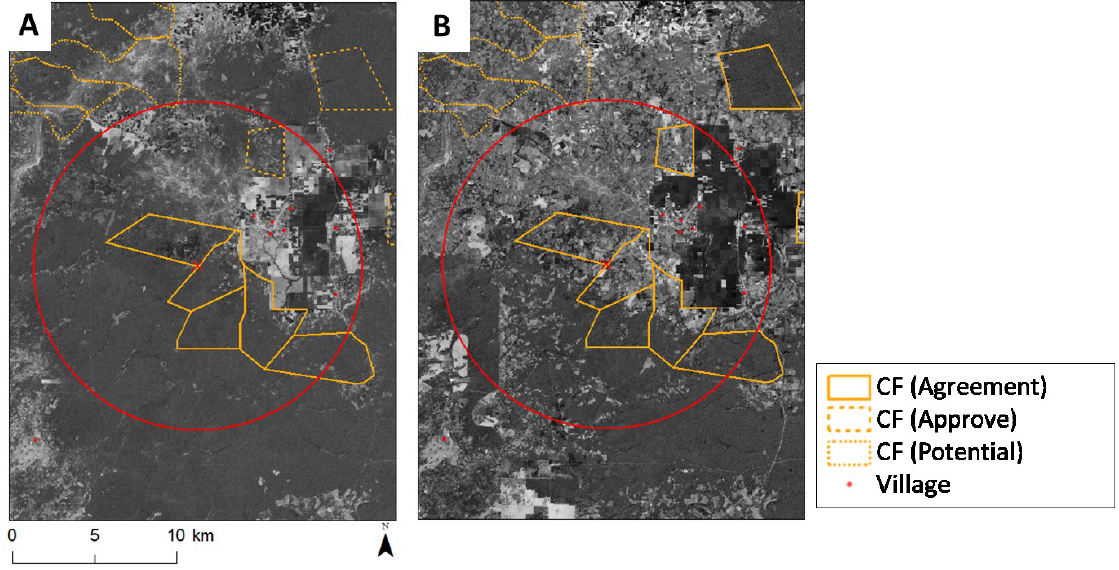
Figure 5. Recent changes in land cover and community forestry (CF) site status in a heavily-deforested area within and around CF sites. Source: NDVI of ( A ) Landsat 5 TM taken on 14 January 2009 and ( B ) Landsat 7 taken on 11 January 2014. CF statuses for ( A , B ) were available from the Kampong Thom provincial office of the Forestry Administration are based on the periods of June 2010 and September 2014,